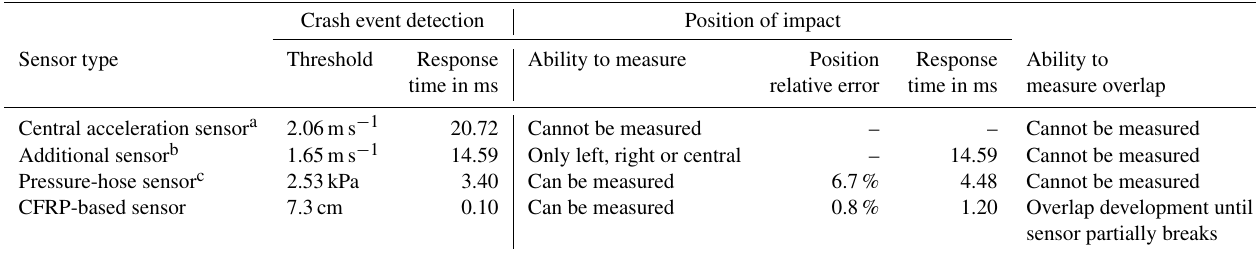
Table 3. Comparison of different sensor